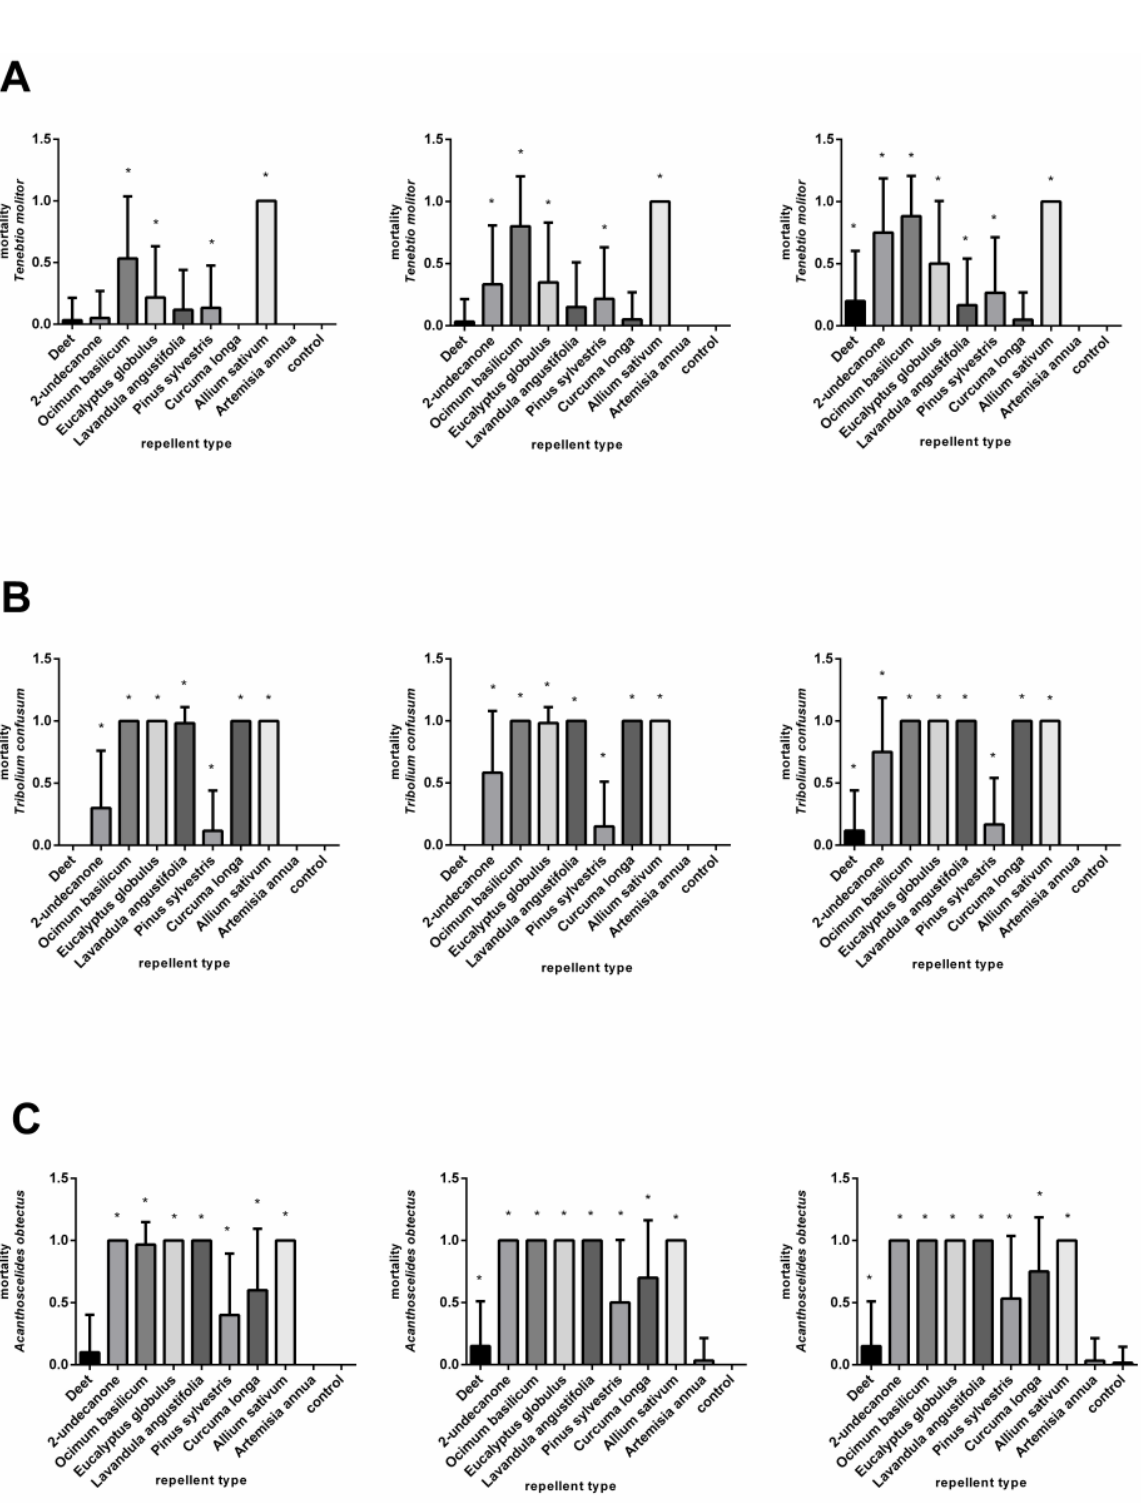
Figure 2. Mortality of Tenebrio molitor ( A ), Tribolium confusum ( B ), and Acanthoscelides obtectus ( C ) after using chemical products (DEET and 2-undecanone) and essential oils ( Ocimum basilicum , Eucalyptus globulus, Lavandula angustifolia, Pinus sylvestris, Curcuma oblonga, Alium sativum , and Artemisia annua ) at a concentration of 3.7 µ L/cm 2 in comparison to control group. Significant differences are marked with an asterisk (*). The order of the graphs determines the incubation time (24, 48, and 72 h) after application. Each column shows mean of dead individuals and SD.